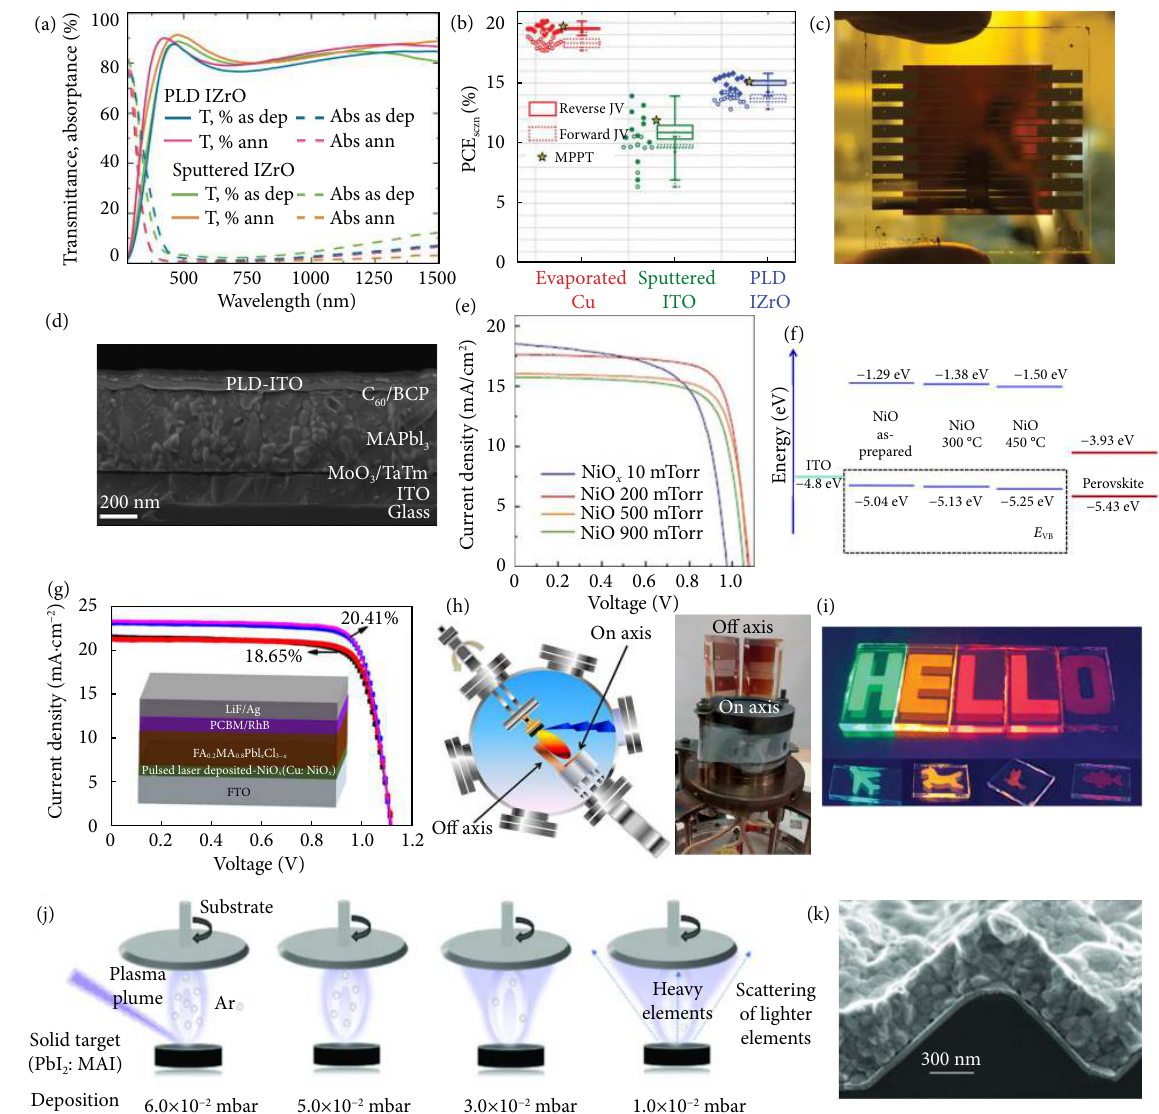
Fig. 8 Applications of PLD for fabricating PSCs. ( a and b ) Transmittance and absorptance spectrum of TCO films deposited by PLD and magnetron sputtering method, respectively (reprinted with permission from ref. [62], © 2021 The Authors). ( c and d ) Photograph (c) and cross-sectional SEM image ( d ) of the all-vacuum deposited semitransparent PSCs with ALD-grown ITO electrode (reprinted with permission from ref. [93], © 2022 The Authors). (e) J–V characteristics of PSCs based on PLD-grown NiO x films, deposited at different oxygen partial pressure (reprinted with permission from ref. [94], © 2015 Wiley VCH). (f) Energy band diagram of PLD-grown NiO at different annealing temperatures (reprinted with permission from ref. [95], © 2017 The Royal Society of Chemistry). (g) J–V curves of PSCs based on Cu doped NiO x and undoped NiO x HTLs and corresponding device structure (reprinted with permission from ref. [96], © 2020 American Chemical Society). (h) Schematic presentation and picture of the substrate arrangement for on-axis and off-axis PLD deposition (reproduced with permission from ref. [101], © 2015 American Chemical Society). (i) Photographs of CsPbI x Br 1− x films under the illumination of an ultraviolet fluorescent lamp (reprinted with permission from ref. [105], © 2021 Wiley-VCH). (j) Schematic illustration of the shape of plasma plume at different pressures. (k) Cross-sectional SEM image of the conformal growth of the PLD-grown perovskite film on textured Si substrate. ( J and k ) Reprinted with permission from ref. [103], © 2021